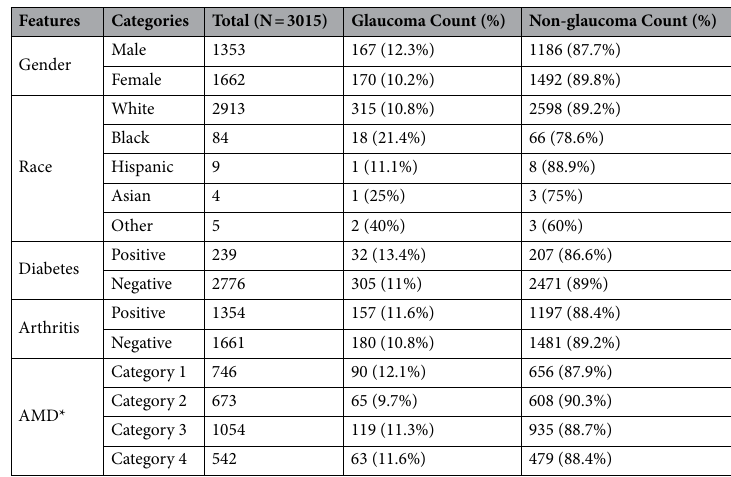
Table 1. Quantitative description of categorical features of subjects at the time of enrollment. *AMD category descriptions 33 . Category 1: A few small or no drusen. Category 2: Many small drusen or a few medium-sized drusen in one or both eyes. Category 3: Many medium-sized drusen or one or more large drusen in one or both eyes. Category 4: Breakdown of light-sensitive cells and supporting tissue in the central retinal. Area or abnormal and fragile blood vessels under the retina.